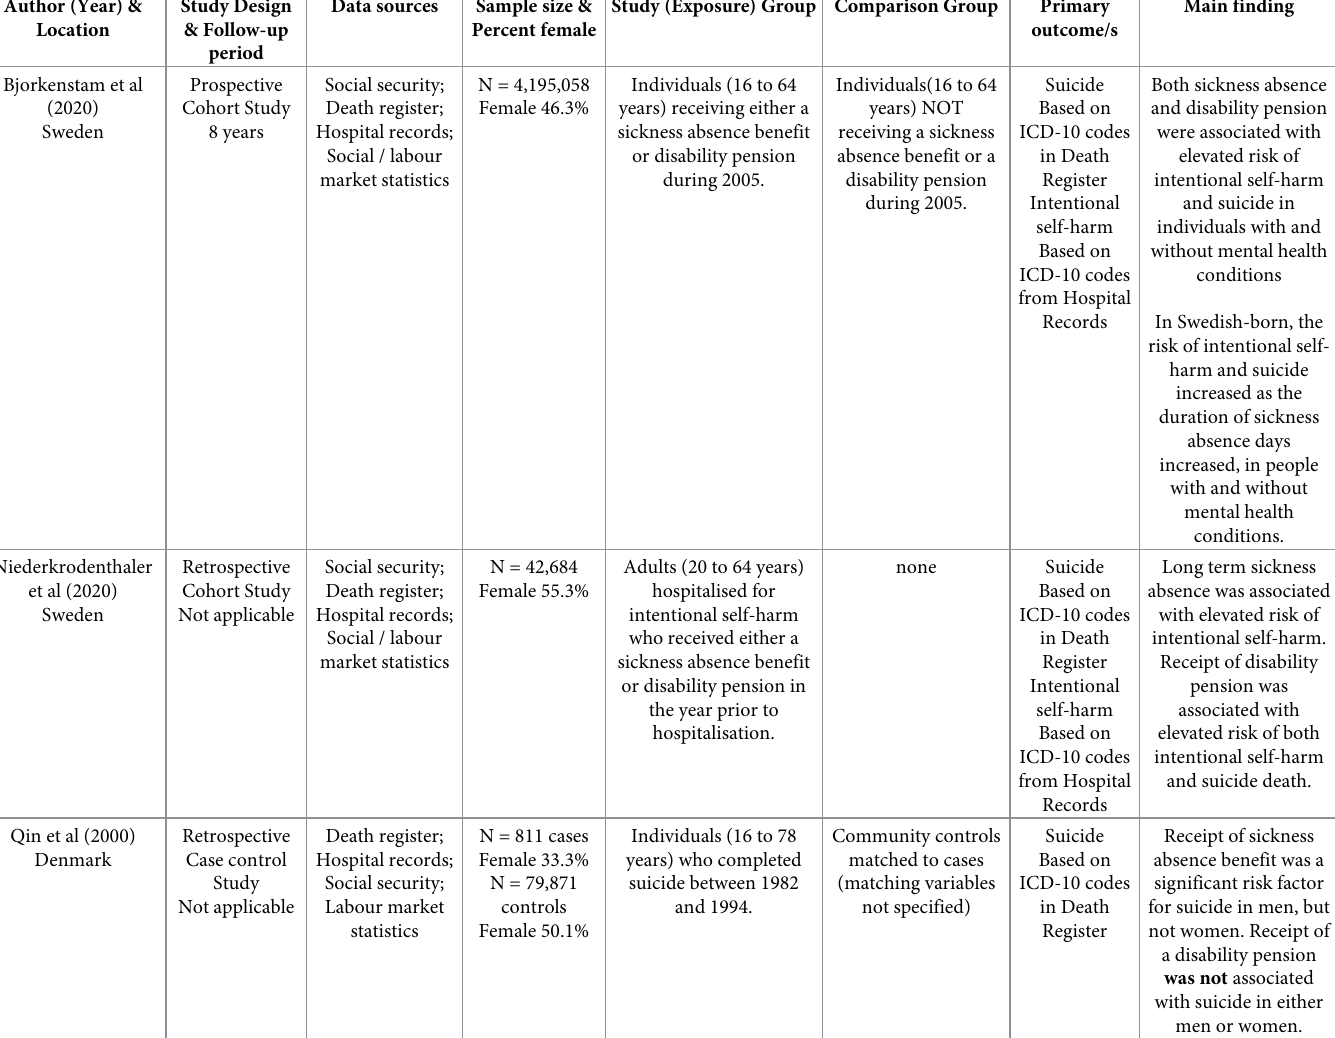
Table 4. Summary of mixed sickness absence / disability pension